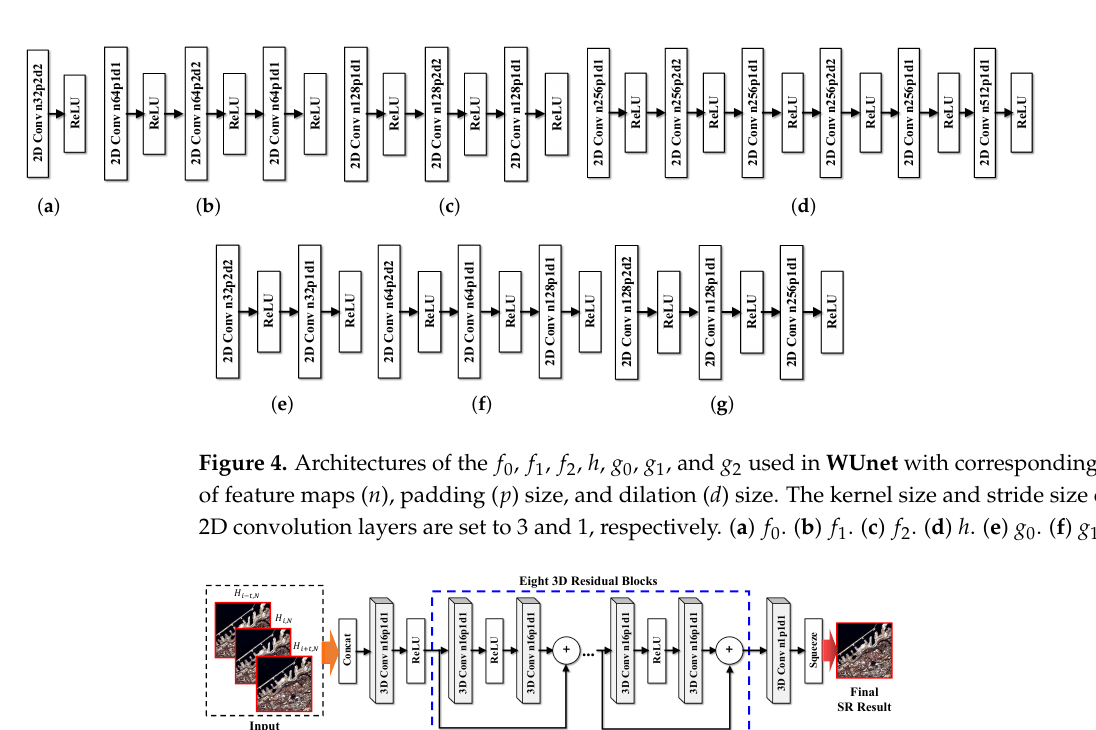
Figure 3. Architectures of the wavelet-based denoise subnetwork WUnet with corresponding number of feature maps ( n ), padding ( p ) size, and dilation ( d ) size. The kernel size and stride size of all the 2D convolution layers are set to 3 and 1, respectively.